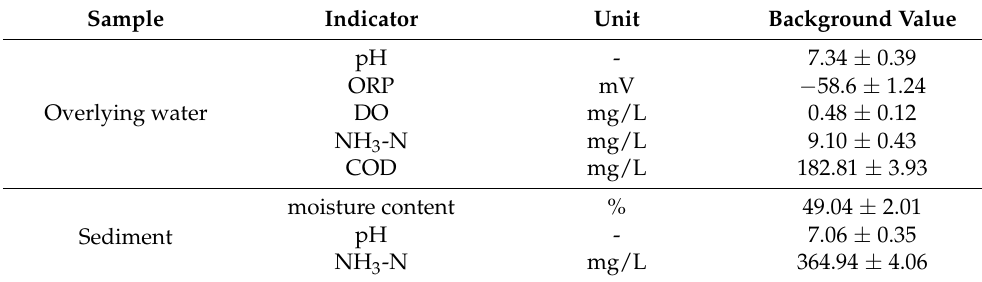
Table 1. Physical and chemical properties of experimental